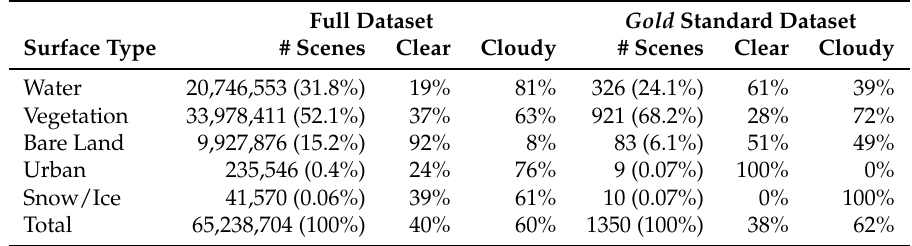
Table 3. Surface types considered in the paper, their numerosity and percentage of Clear and Cloudy scenes in both the full joint MODIS and SEVIRI and the gold standard dataset.